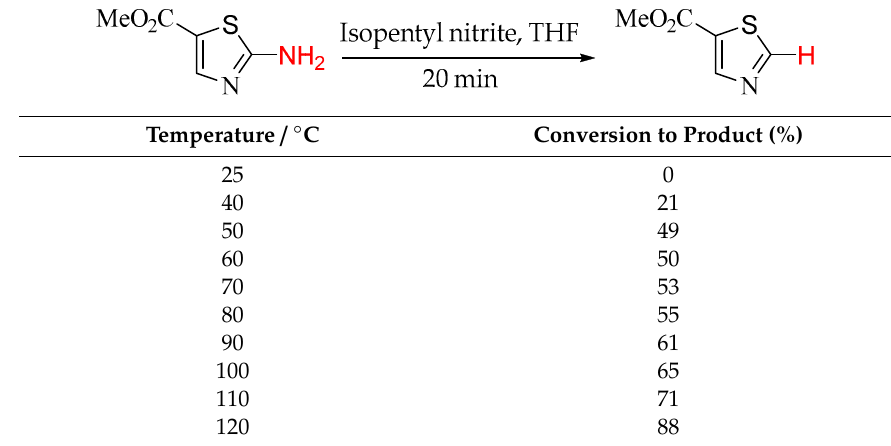
Table 2. Conversion of methyl 2-aminothiazole-5-carboxylate ( 1a ) to methyl thiazole-5-carboxylate ( 2a ) at various temperatures in THF.